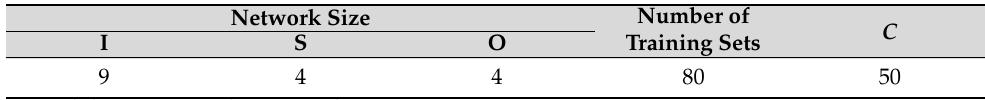
Table 3. Architecture of the BSVR.